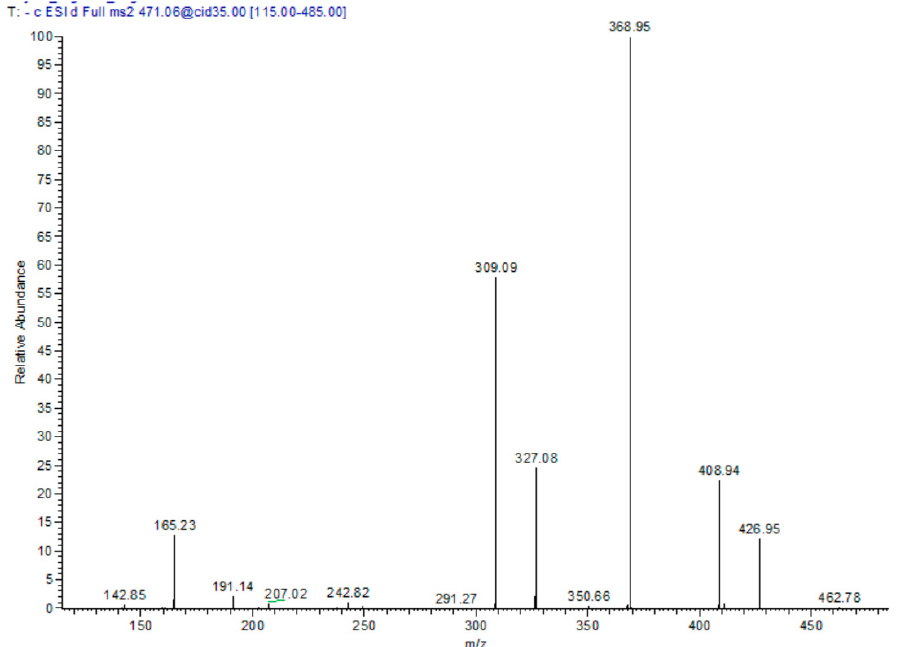
Figure 2. MS/MS spectra of compound 13: phloretic acid caffeoyl 3-hydroxy-3-methylglutaroyl in the Figure 2. MS / MS spectra of compound 13: phloretic acid ca ff eoyl 3-hydroxy-3-methylglutaroyl in the negative ion mode. negative ion mode. Table 2. In vitro cyclooxygenase (COX-1 and COX-2) and lipoxygenase (5-LOX) inhibition (IC 50 ) and the total antioxidant capacity (U / L) of T. algeriensis and T. fontanesii extracts. Treatment